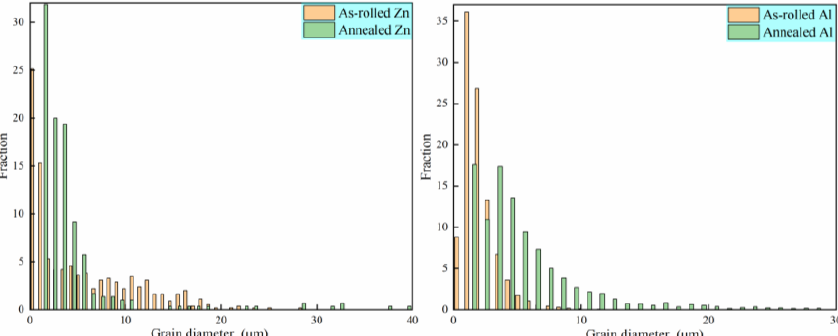
Figure 9. Grain distribution diagram of Al side and Zn side for rolling state and 280 °C × 2 h.